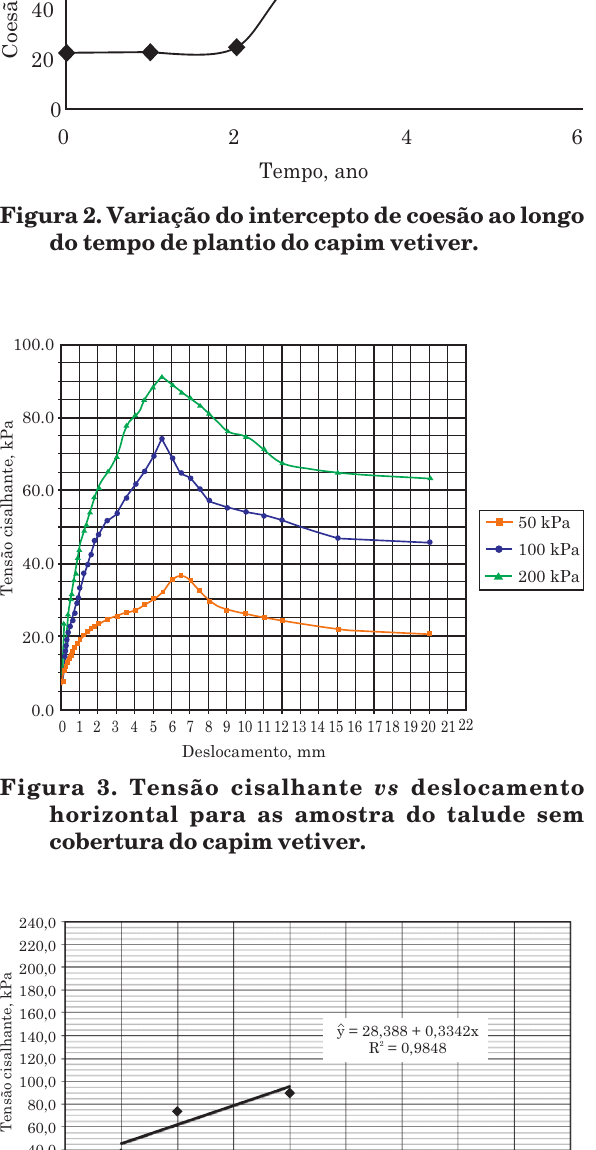
R. Bras. Ci. Solo, 37:113-120